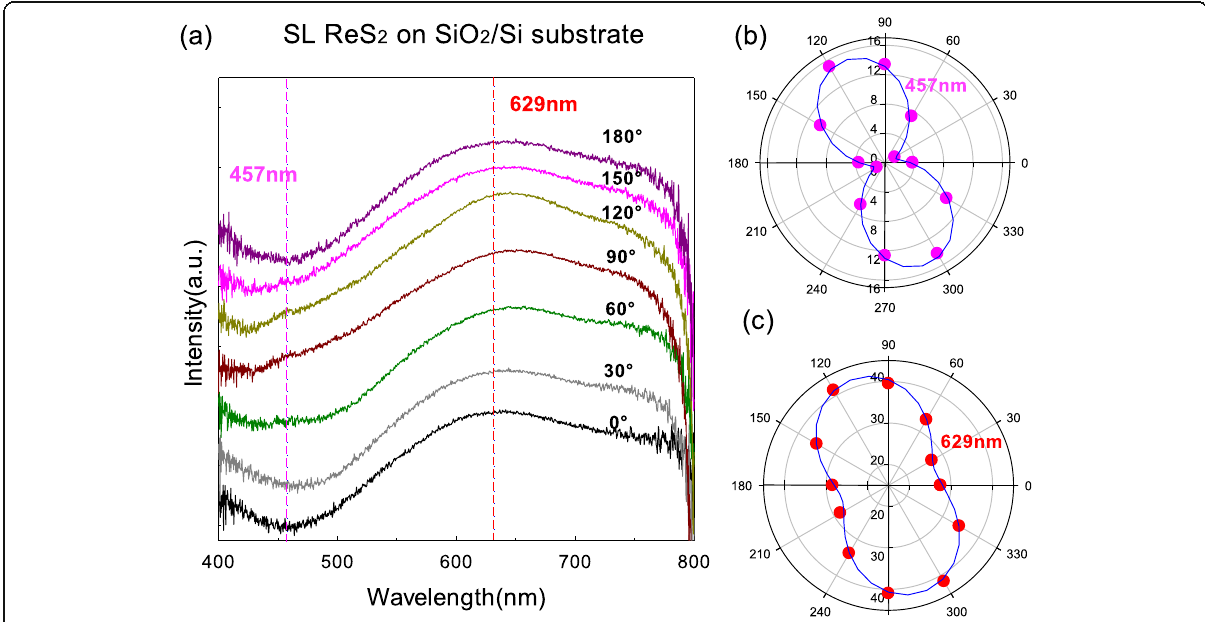
Fig. 2 a The polarization optical contrast curves of SL ReS 2 flakes supported on SiO 2 /Si substrate. b The intensity variation at ~ 457 nm from 0 to 360°. c The intensity variation at ~ 629 nm from 0 to